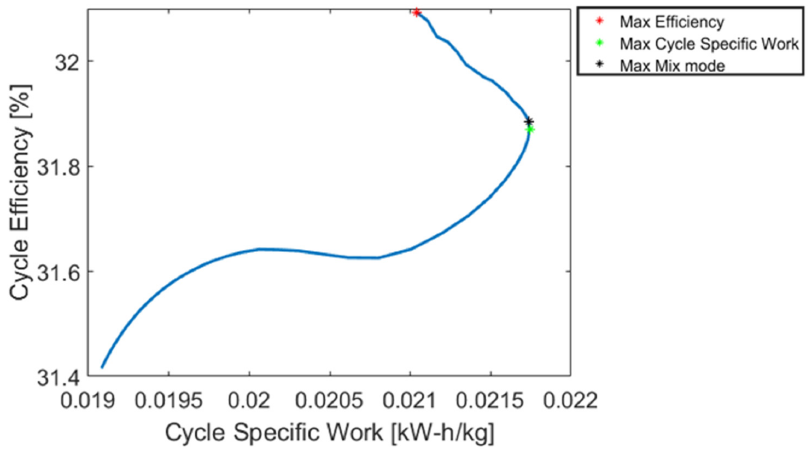
Figure 22. Cycle Efficiency along the cycle Specific Work of S-CO 2 Brayton cycle. Using these turbomachinery isentropic efficiencies at each turbine pressure ratio, the cycle efficiency, cycle specific work, and the mix mode were calculated as shown in Figure 21, where the red points on the plots represent the maximum point of corresponding pa- rameters. Figure 22 shows the cycle efficiency plotted over the cycle specific work, where the red, black, and green points represent the point at which the cycle efficiency, cycle specific work, and the mix mode, respectively, were maximized. Similar to the open-air Brayton cycle, if the cycle is optimized with the maximum cycle efficiency, the cycle spe- cific work is relatively lower than that in the cycle optimized with the maximum cycle specific work. However, the cycle optimized with the mix mode is almost the same as the cycle optimized with the specific work. The same trend continues in Figures 23–25. Figure 23. ( a ) Cycle efficiency and ( b ) cycle mass flow rate of S-CO 2 Brayton Cycle.